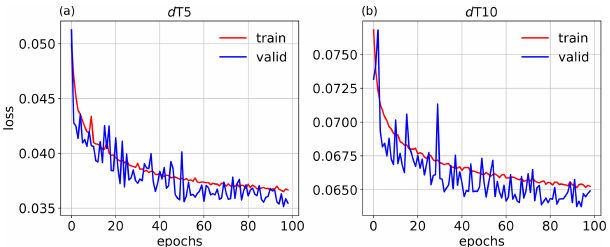
Figure 2. Value of the loss function J averaged over samples for the training (red) and validation (blue) data set as a function of epochs for dT5 (a) and dT10 (b)